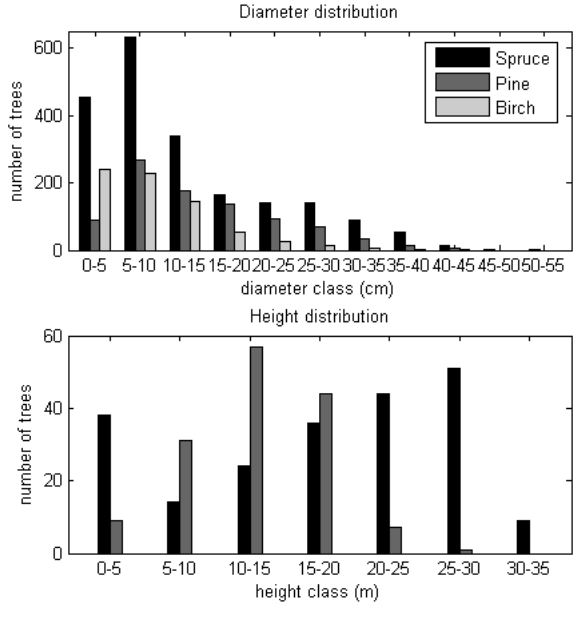
Figure 3. Tree diameter at breast height (top) and height distribution (bottom) of the plots surveyed in the field; Note: no height measurements were performed for birch